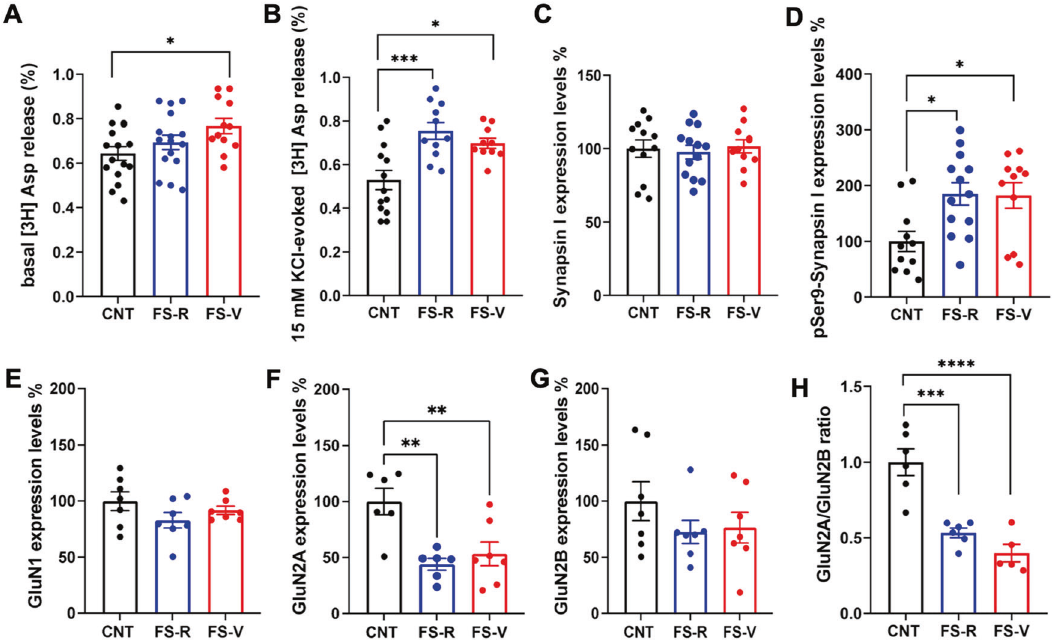
Fig. 3 Glutamate release from PFC synaptosomes and protein expression and phosphorylation of AMPA and NMDA receptor subunits in PFC synaptosomes. A Basal [ 3 H]-Asp release. One-way ANOVA, Tukey ’ s post-hoc test: * p < 0.05; N = 16 (CNT), 16 (FS-R), 12 (FS-V). B 15 mM KCl- evoked [ 3 H]-Asp release. One-way ANOVA, Tukey ’ s post-hoc test: * p < 0.05, *** p < 0.001; N = 13 (CNT), 11 (FS-R), 10 (FS-V). C Total synapsin-I protein expression levels in PFC synaptic membranes. One-way ANOVA; N = 12 (CNT), 13 (FS-R), 11 (FS-V). D Phospho-Ser 9 synapsin-I protein expression levels in PFC synaptic membranes. One-way ANOVA, Tukey ’ s post-hoc test: * p < 0.05; N = 11 (CNT), 13 (FS-R), 11 (FS-V). E GluN1, ( F ) GluN2A ( G ) GluN2B protein expression levels, and ( H ) GluN2A/2B ratio in PFC synaptic membranes. E , H One-way ANOVA, Tukey ’ s post-hoc test: *** p < 0.001, **** p < 0.0001. F , G Kruskal-Wallis, Dunn ’ s post-hoc test: ** p < 0.01, N = 6/7 (CNT), 6/7 (FS-R), 6/7 (FS-V).